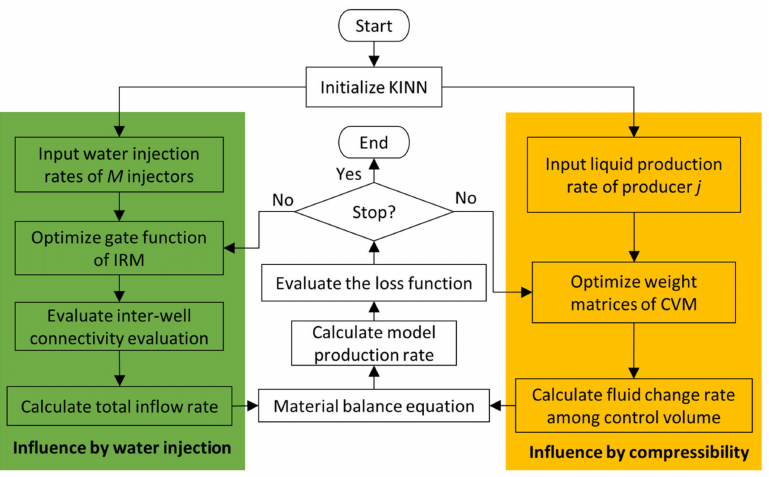
Figure 4. Flow diagram of KINN training.